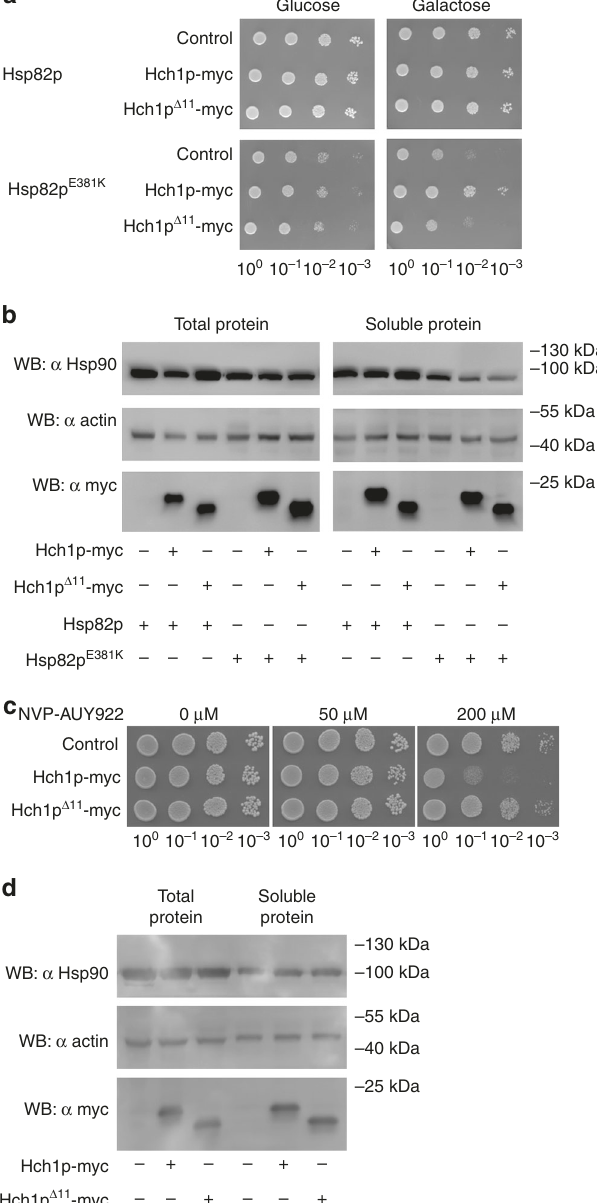
Fig. 4 The NxNNWHW motif is required for Hch1p function in vivo. a Overexpression of myc-tagged Hch1p, but not Hch1p Δ 11 , rescues growth defects of yeast expressing Hsp82p E381K . Yeast expressing wildtype plasmids encoding the indicated co-chaperones were grown overnight